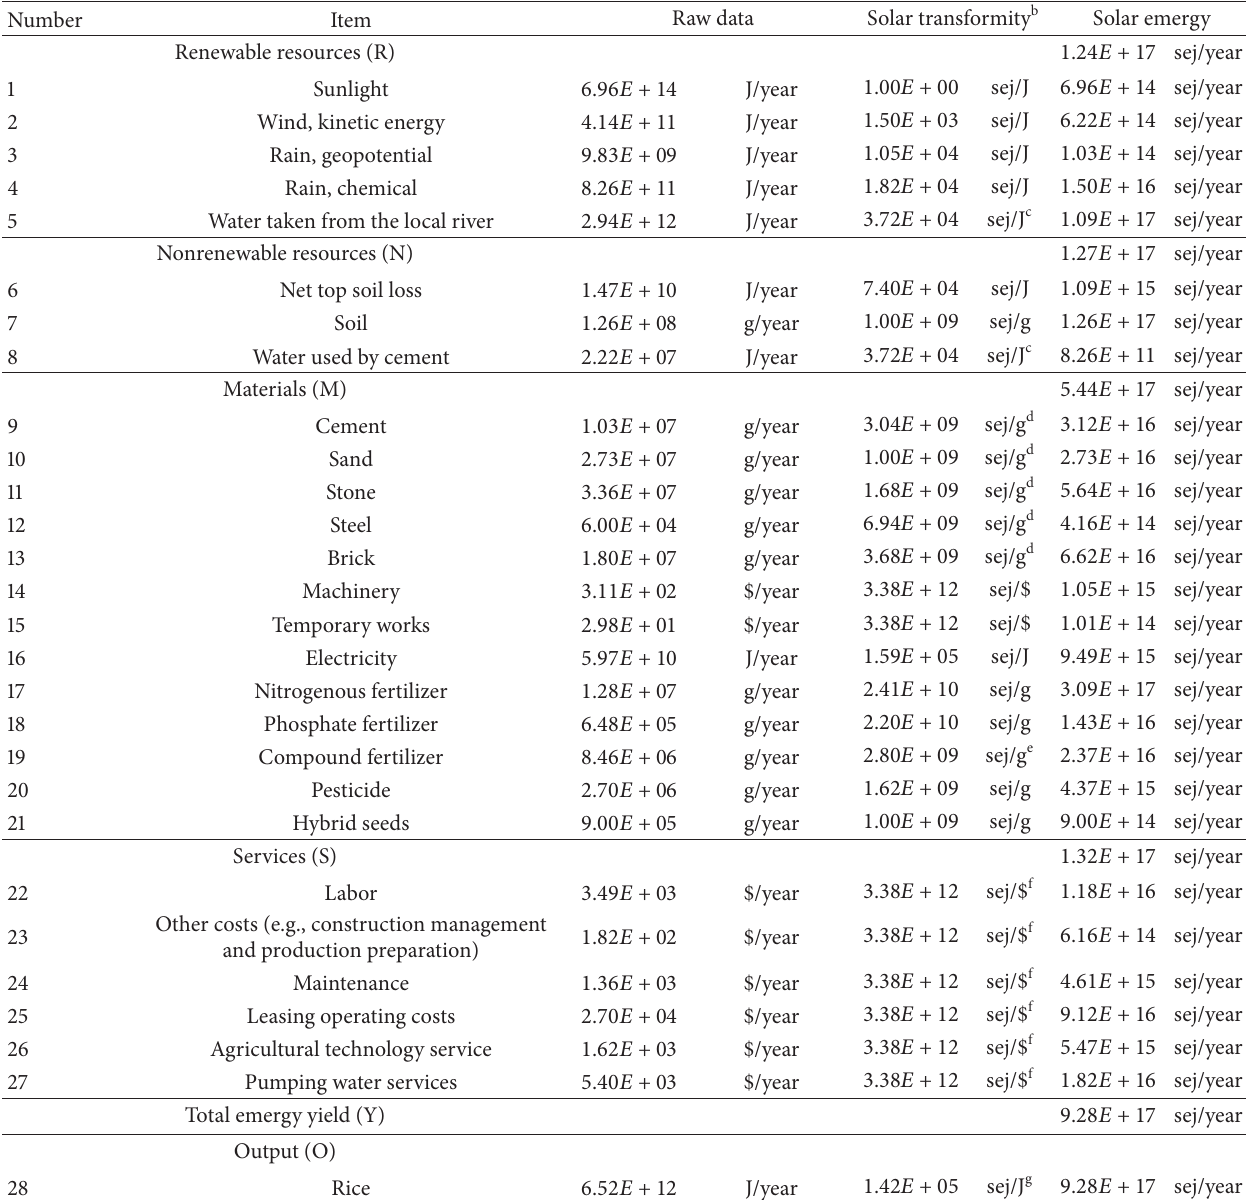
Table 4: Emergy evaluation of the integrated system of irrigation water production and irrigated agriculture a .